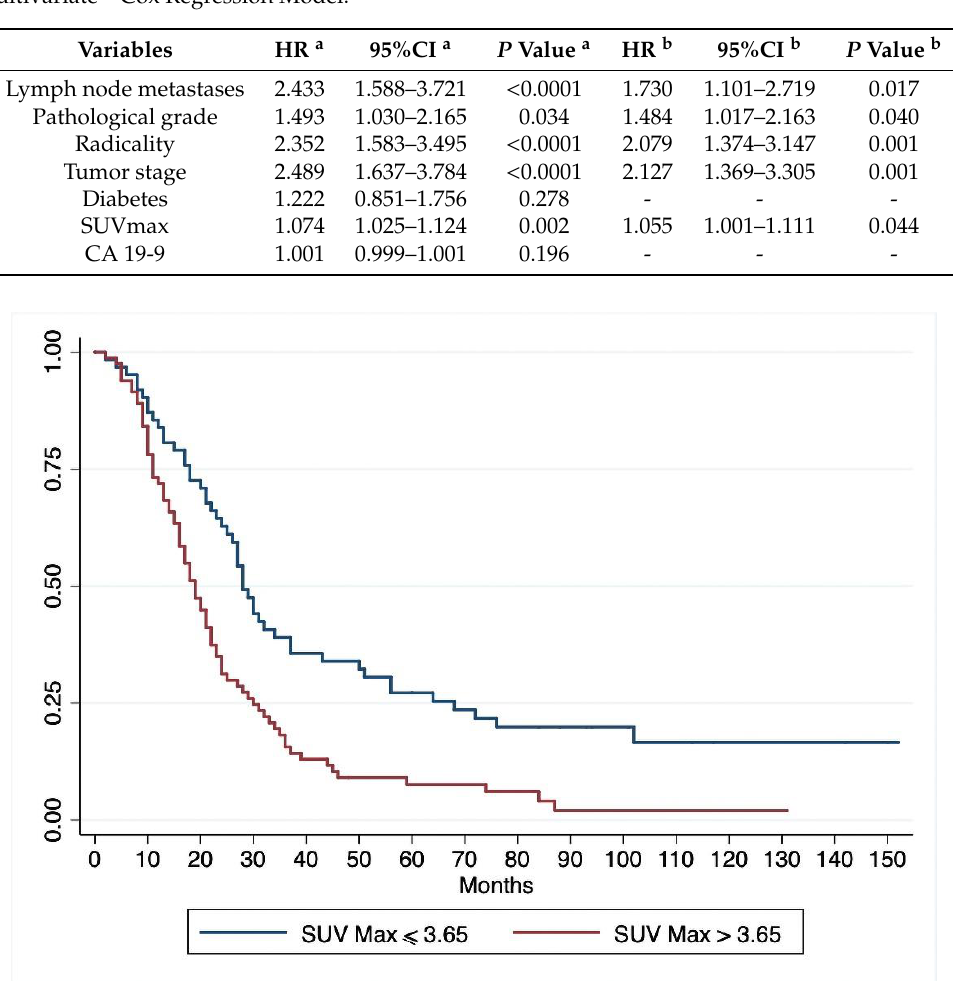
Figure 4. Kaplan–Meier curves for overall survival of patients with preoperative SUVmax > 3.65 and those with SUVmax ≤ 3.65.